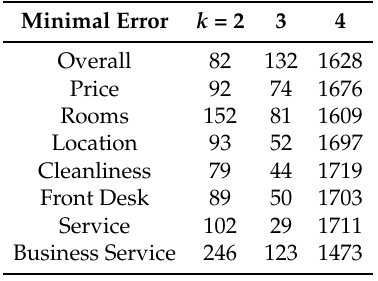
Table 15. Number of times k minimizes error with rounding.